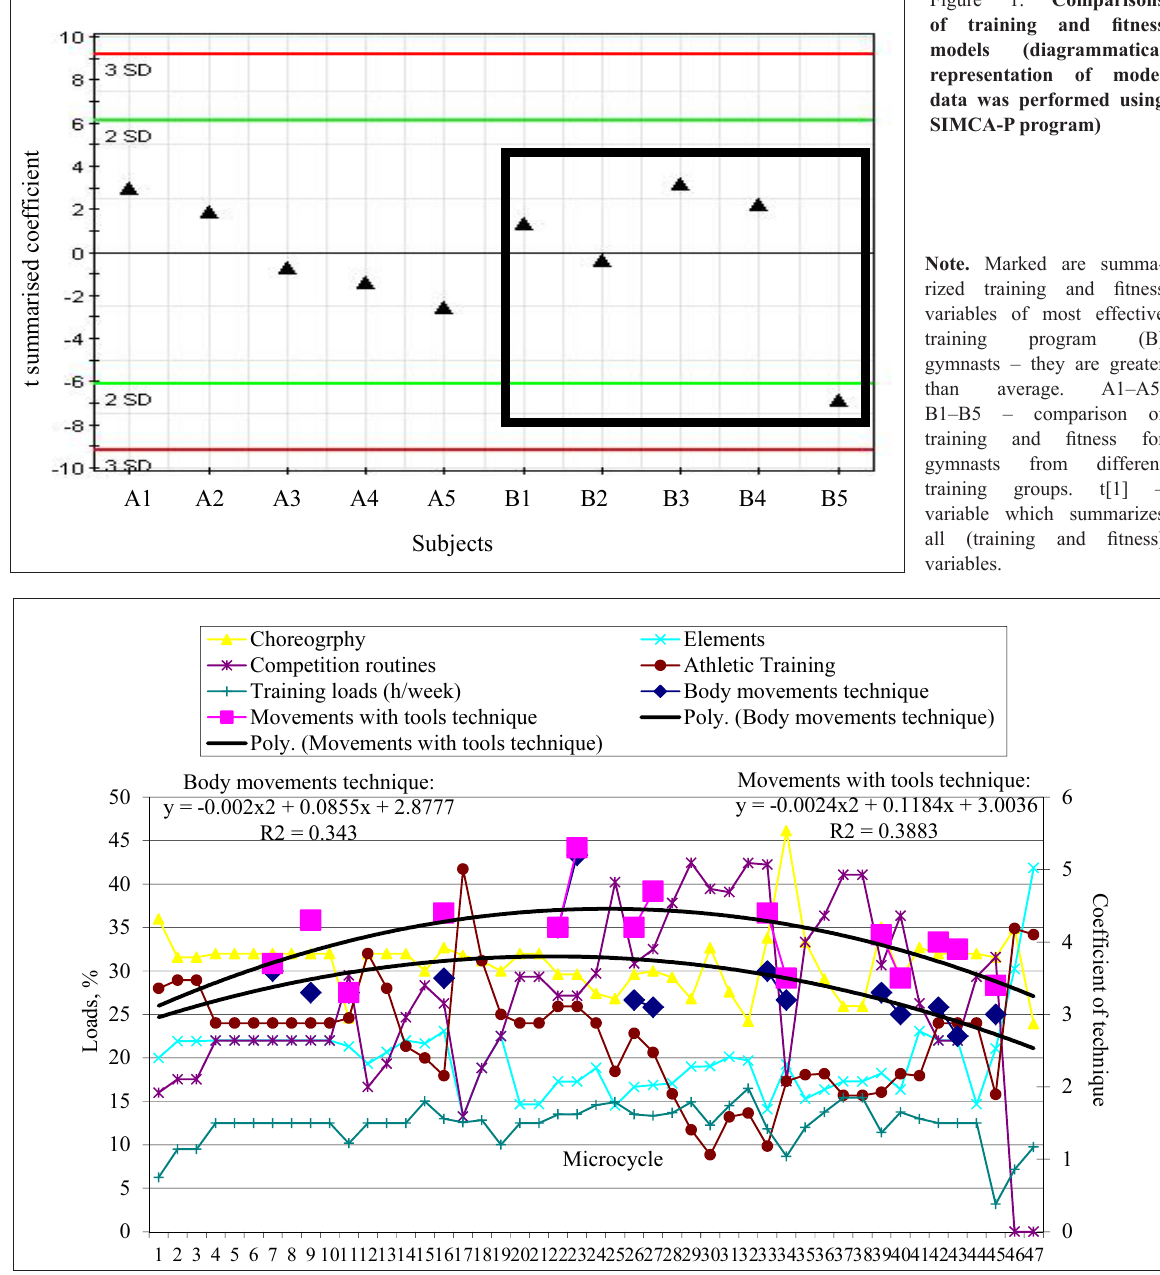
Figure. 2. Changes in the training loads (%), training content and the difficulty of technique in different micro-cycles in the most effective training program for 14–15-year-old gymnasts in the experiment of athlete training